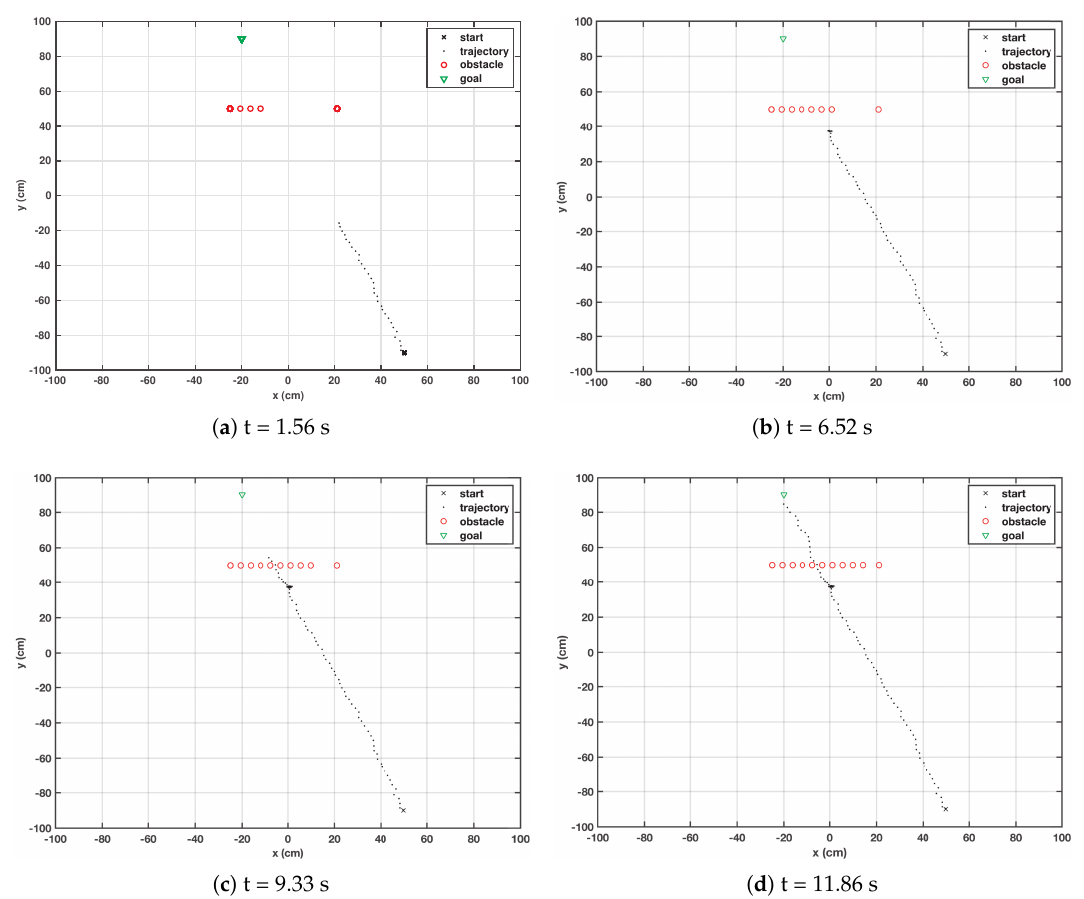
Figure 3. Trajectory of the robot when a moving obstacle is